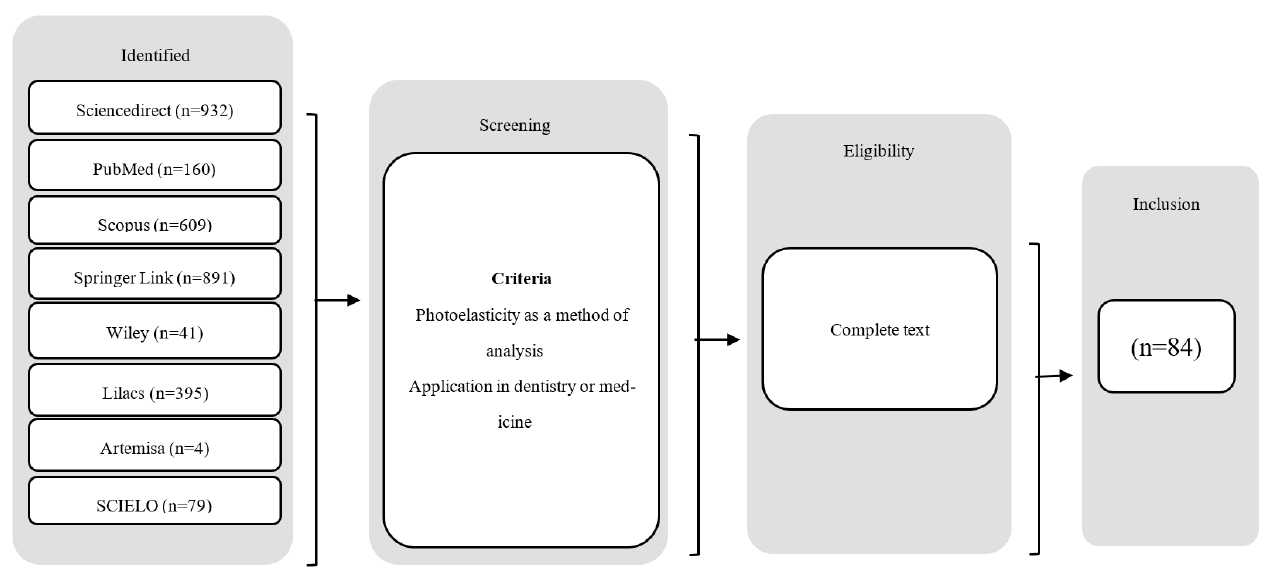
Figure 1. Number of publications in dentistry and medicine.